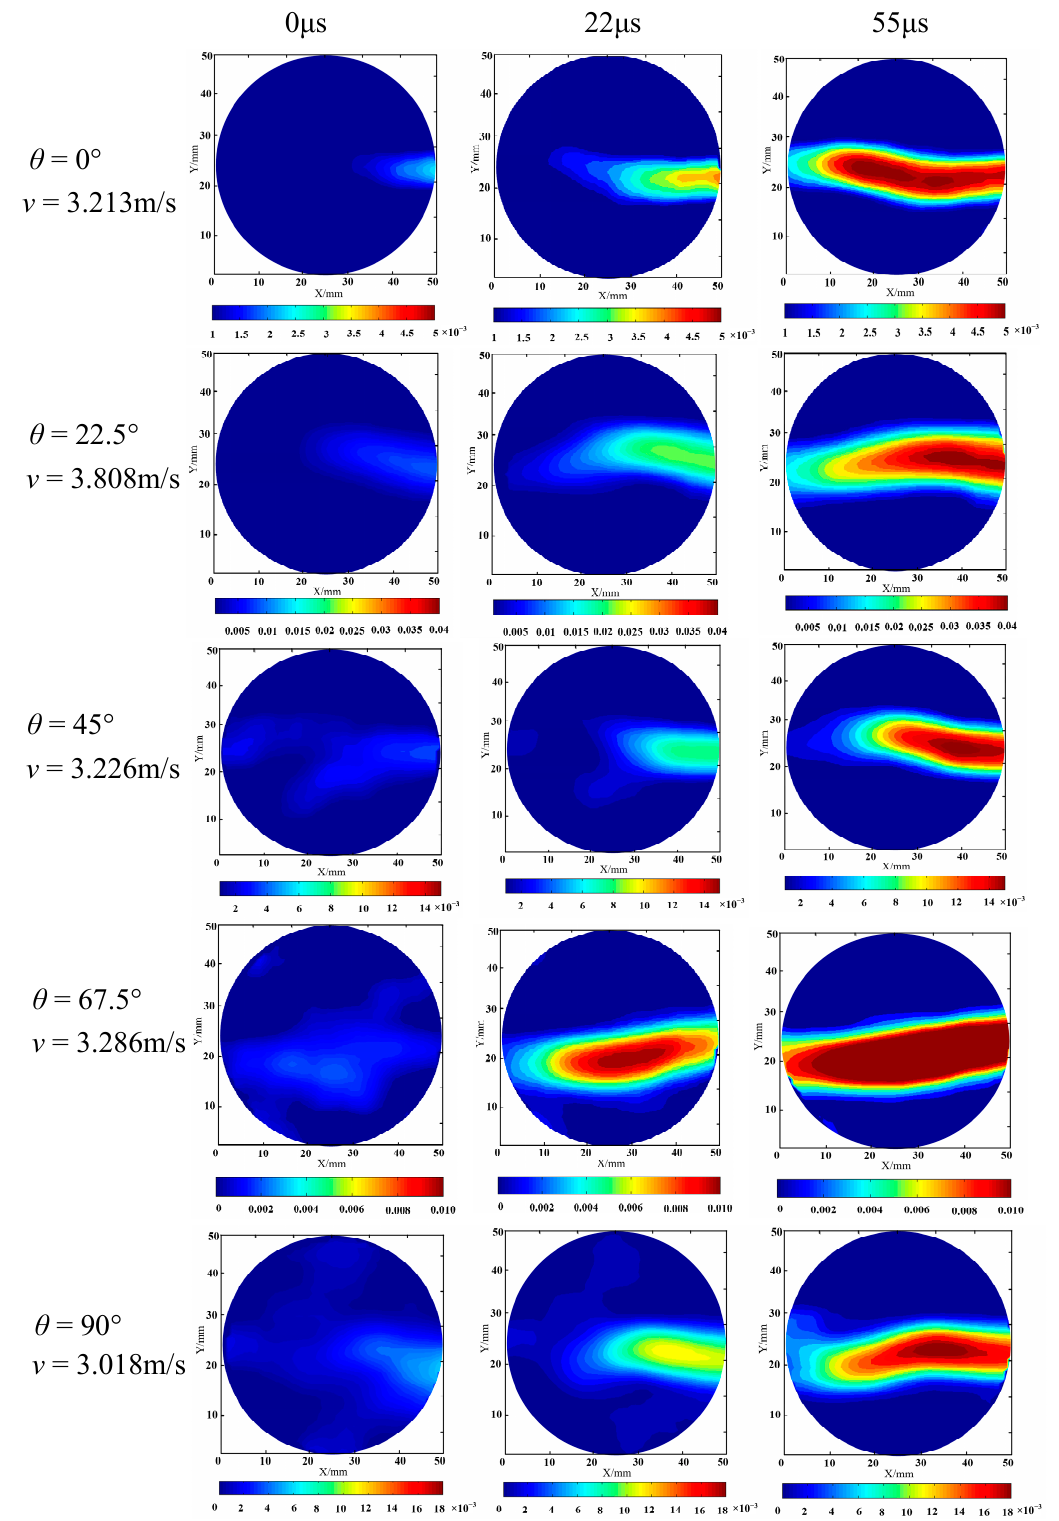
Figure 14. Evolution of strain field in dynamic tensile process of representative outburst-prone coal.